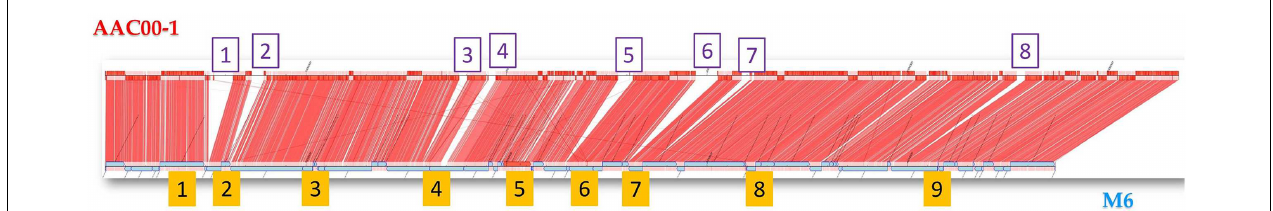
FIGURE 1 | Synteny between the genomes of Acidovorax citrulli strains M6 (bottom) and AAC00-1 (top) using CONTIGuator (Galardini et al., 2011). The eight boxes at the (top) represent the 8 AAC00-1 DNA fragments that are absent in the M6 genome (FA fragments). The nine boxes at the (bottom) represent the reference fragments (RFAs) that were used as controls for coverage analyses of various A. citrulli strains. Length and nucleotide positions of FA and RFA fragments in the AAC00-1 genome are detailed in Supplementary Table S2.